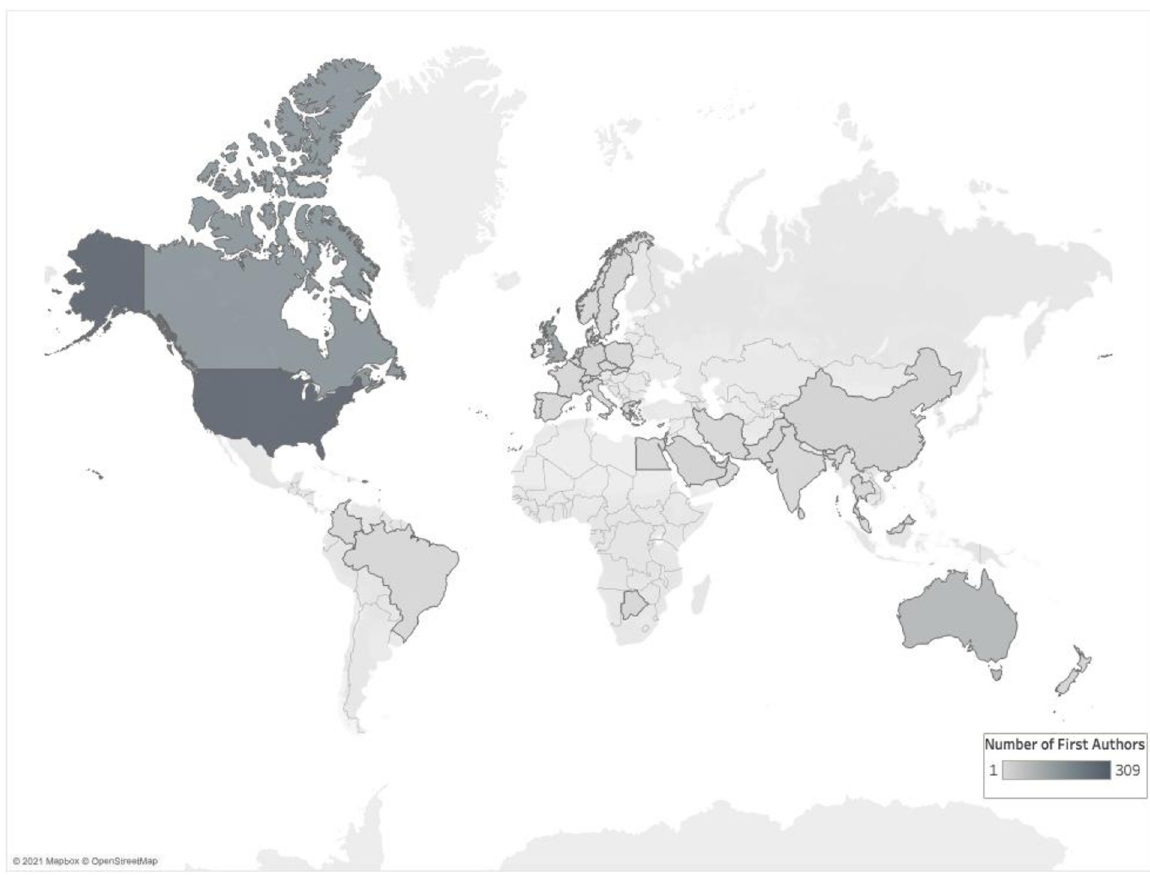
Fig 4. Map highlighting the 42 countries listed as affiliations of first authors of knowledge syntheses published in 14 core medical education journals published between 1999–2019. Contains information from OpenStreetMap and OpenStreetMap Foundation, which is made available under the Open Database License.